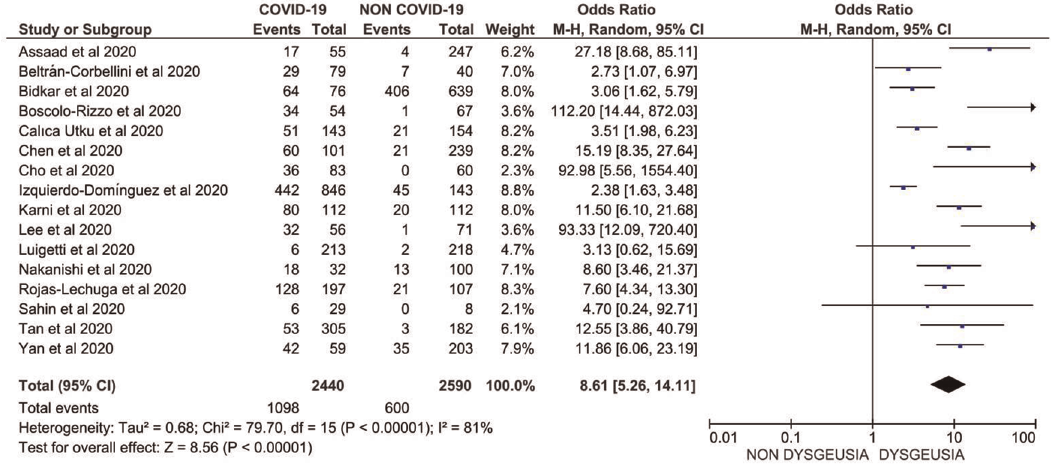
Figure 3. Forest plot of the association between dysgeusia and the risk of COVID-19 (OR: 8.61; 95%CI: 5.26, 14.11; p<0.001; Egger ’ p=0.8220; heterogeneity p<0.001; I-squared